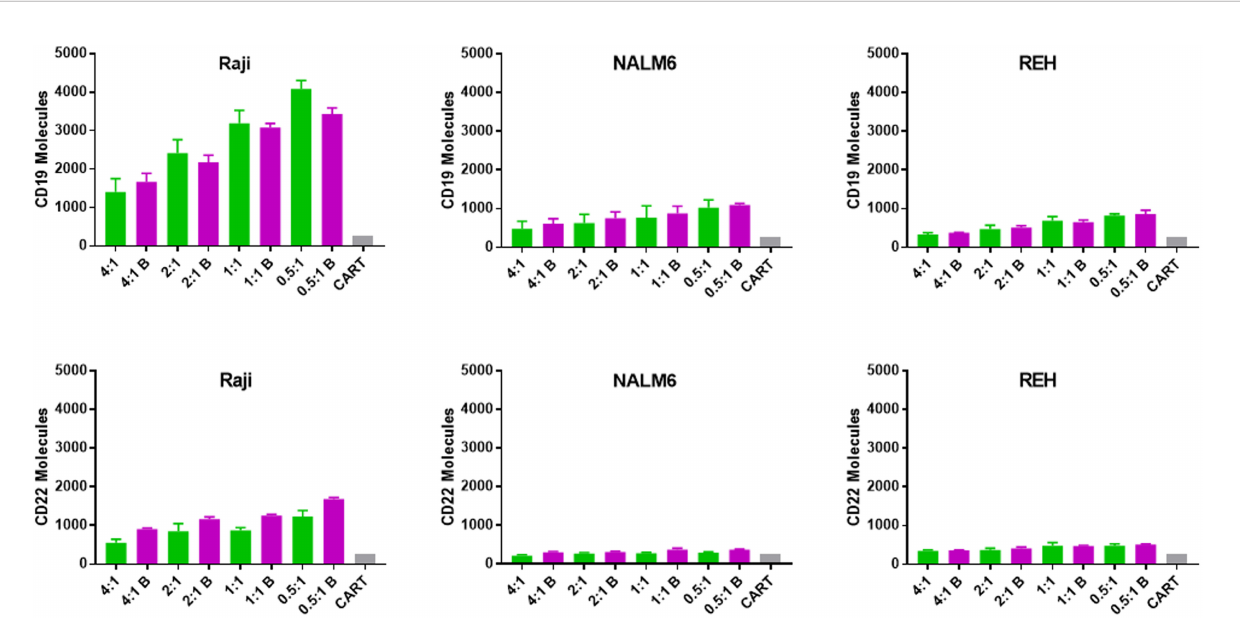
FIGURE 5 | Transfer of CD19 and CD22 to CD22 CAR-T following overnight culture with leukemia cell lines. The number of CD19 and CD22 molecules acquired by anti-CD22 CAR-T (trogocytosis) was quanti fi ed using Quanti-Brite analysis, as per Figure 3 , however in this case the T cells were analyzed. Average antigen expression and standard deviation are shown. Background signal is shown as a gray bar for each subgroup (CART). The x-axis lists the anti-CD22 CAR-T to leukemia cell ratio (E:T) used for each condition and indicates if the leukemia line had been treated with bryostatin (B, magenta